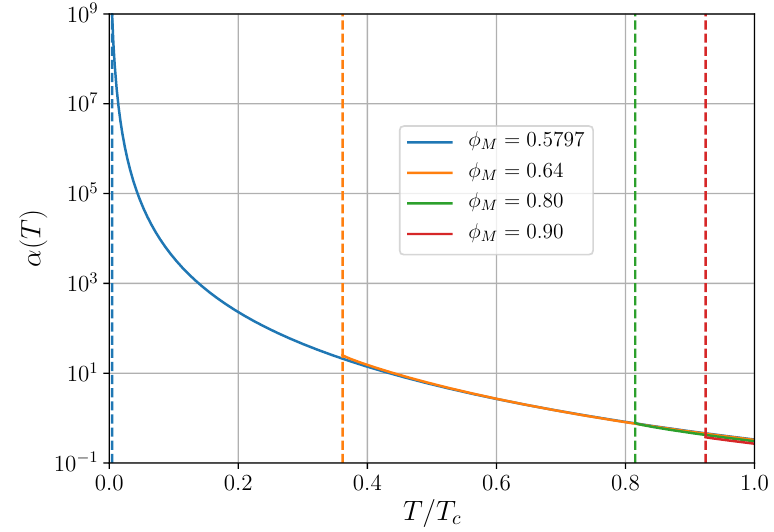
Figure 8 . Temperature dependence of the transition strength parameter α in terms of T/T c for φ Q = 10 . 0 . The dashed lines represent at which value the original, high-temperature minimum is no longer separated by a potential barrier and so disappears, as seen in figure